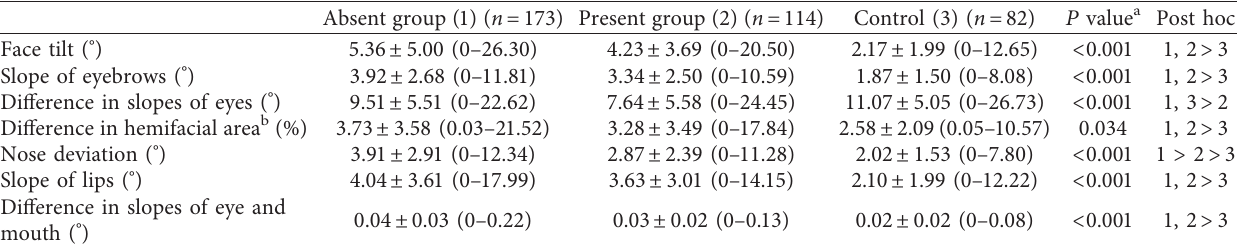
Table 2: Objective measurement of facial asymmetry features in congenital superior oblique palsy patients with the absence of a trochlear nerve (absent group) or presence of a trochlear nerve (present group) compared with